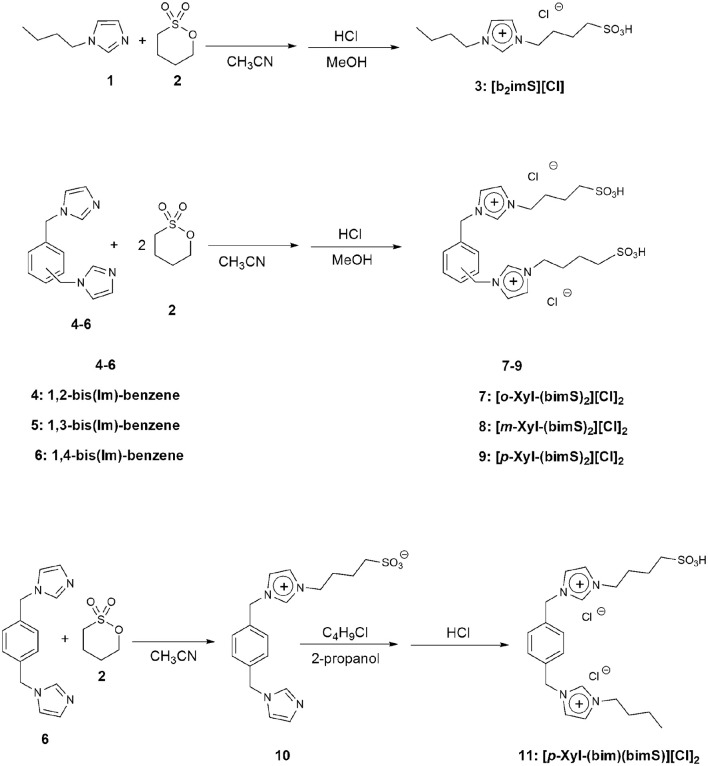
Synthetic steps for the sulfonic acid functionalized imidazolium salts employed.